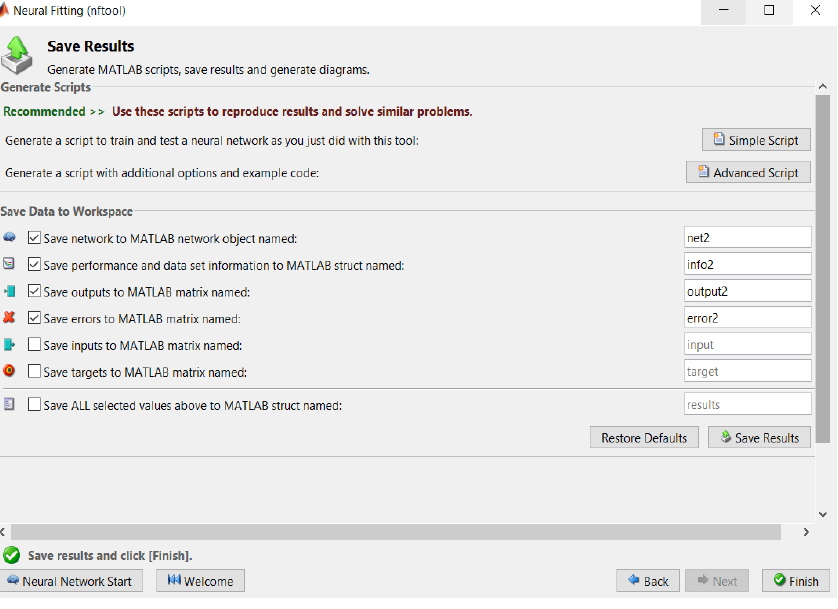
Figure 7. Advance Script.